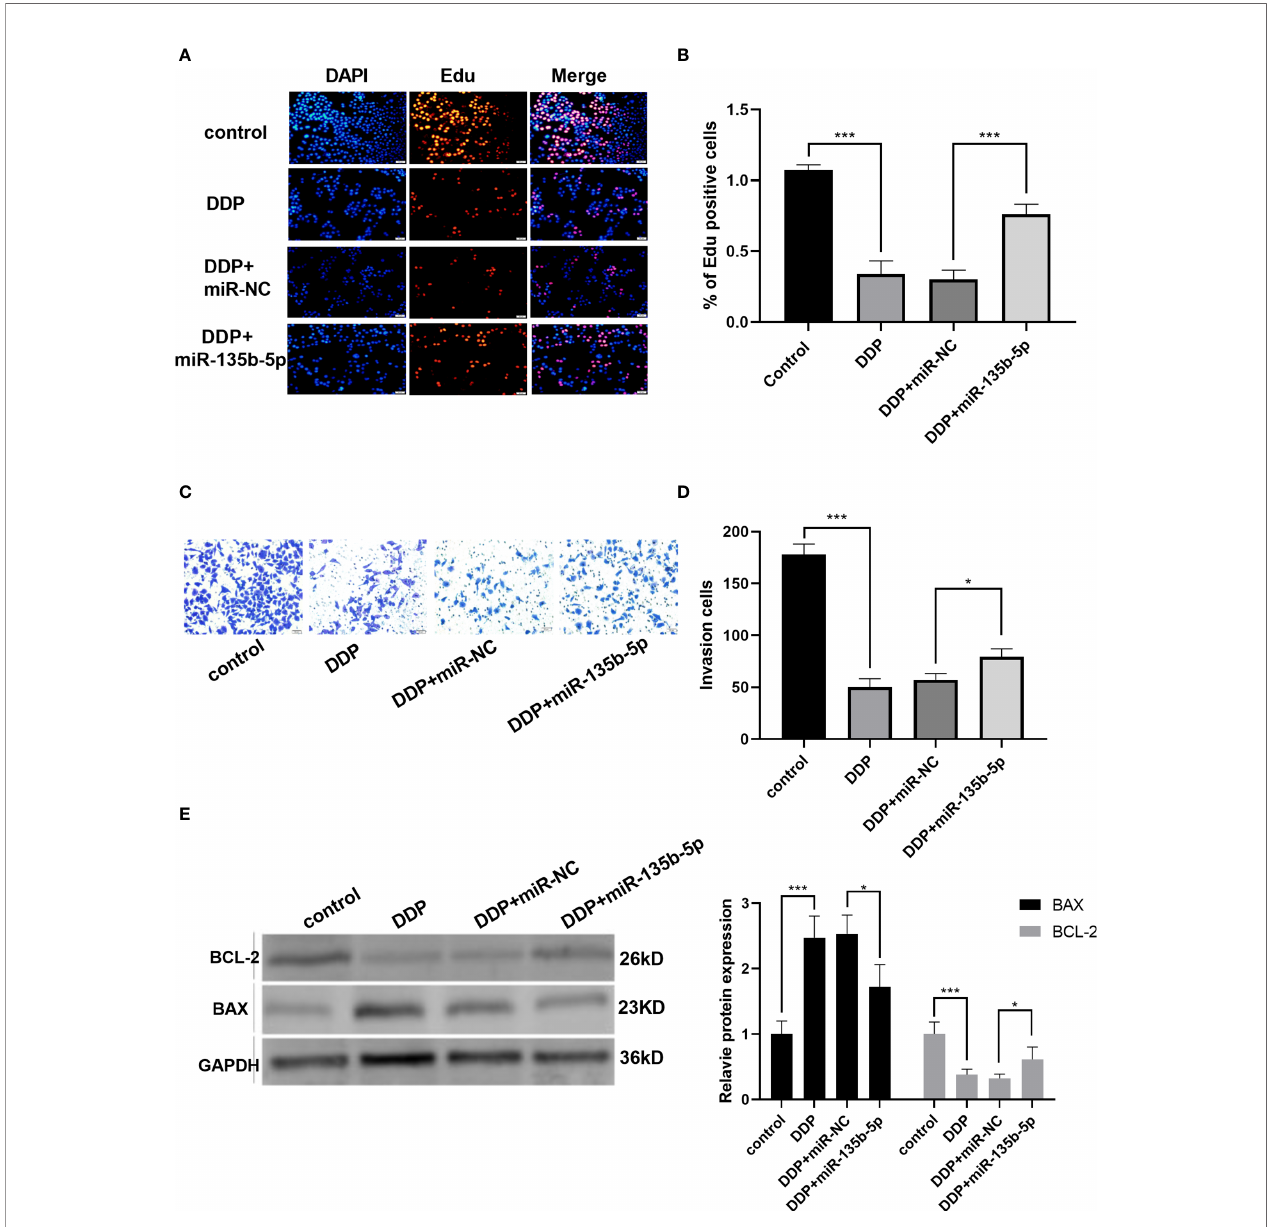
FIGURE 7 | MiR-135b-5p/TXNIP axis contributes to the anti-tumor effect of cisplatin (DDP) for EC. (A, B) Cells proliferation was measured by Edu analysis. Edu (red), nuclear (Hoechest, blue), magni fi cation ×200. (C, D) Transwell assay evaluated the invasion capacity after the intervention of DDP or DDP-mimics, DDP+miR- 135b-5p magni fi cation ×200. (E) Bax and Bcl-2 protein expression level and statistics were showed accordingly. (*p < 0.05, ***p <